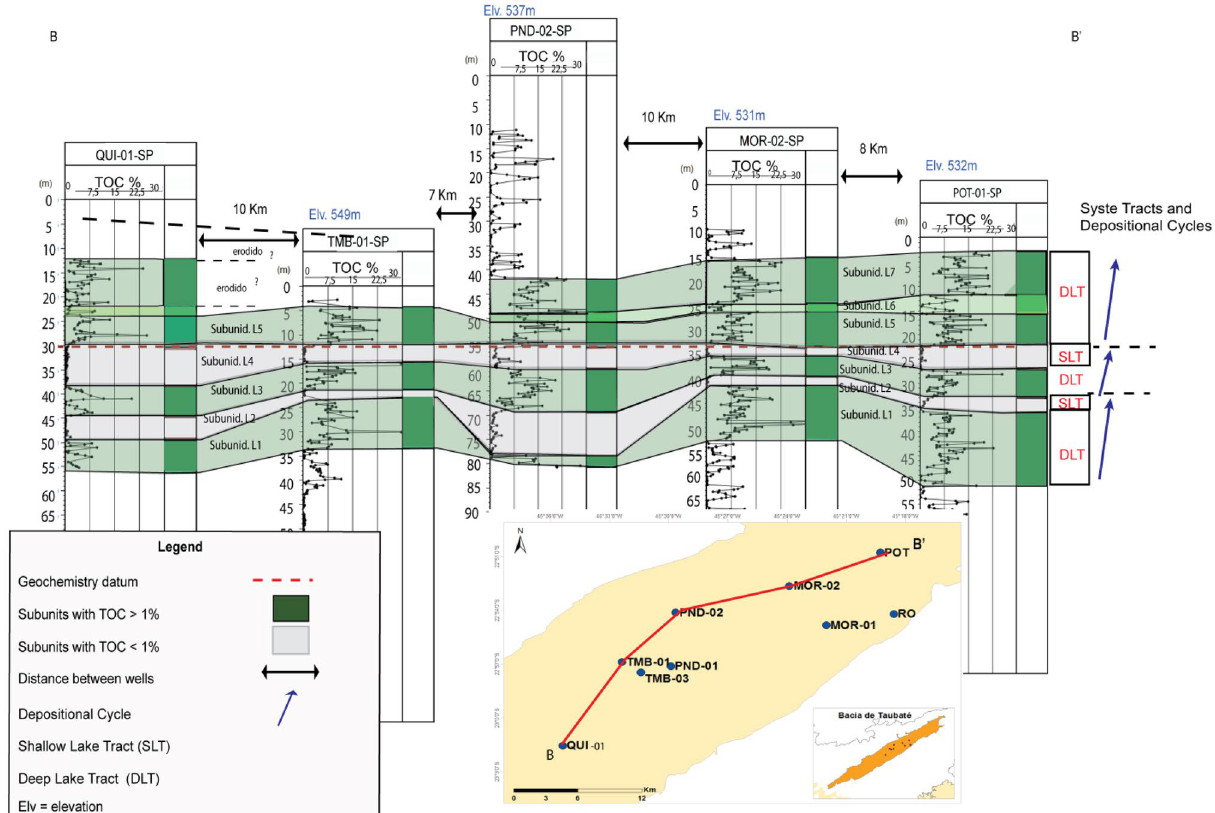
Fig. 5 Correlation B-B’ between wells QUI-SP, TMB-01-SP, PND-02-SP, MOR-02-SP and POT-01-SP, based on TOC